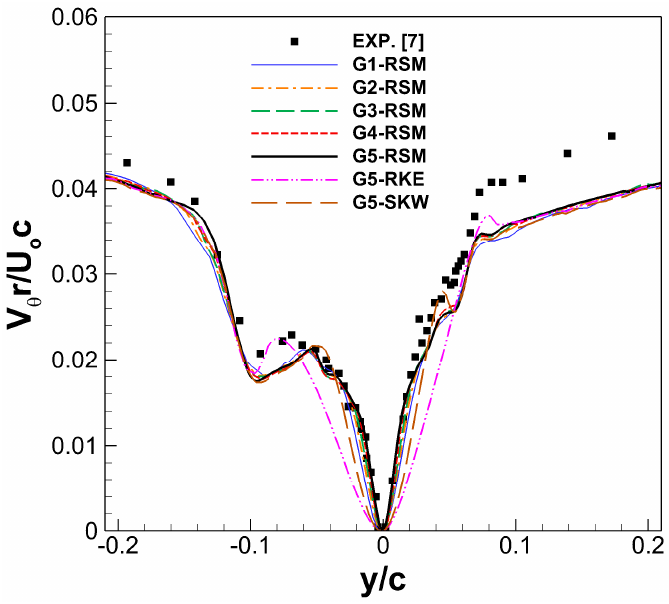
Figure 6. Angular momentum profiles at the section of x/c = 1.0.